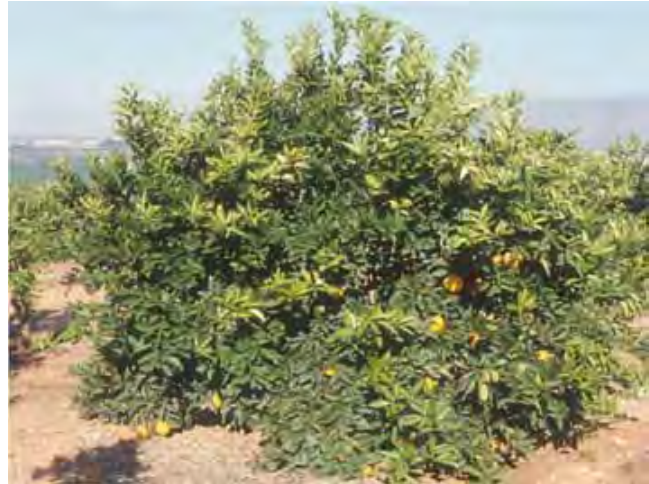
Fig. 2 - ‘Navelate’ orange tree with drooping canopy and full